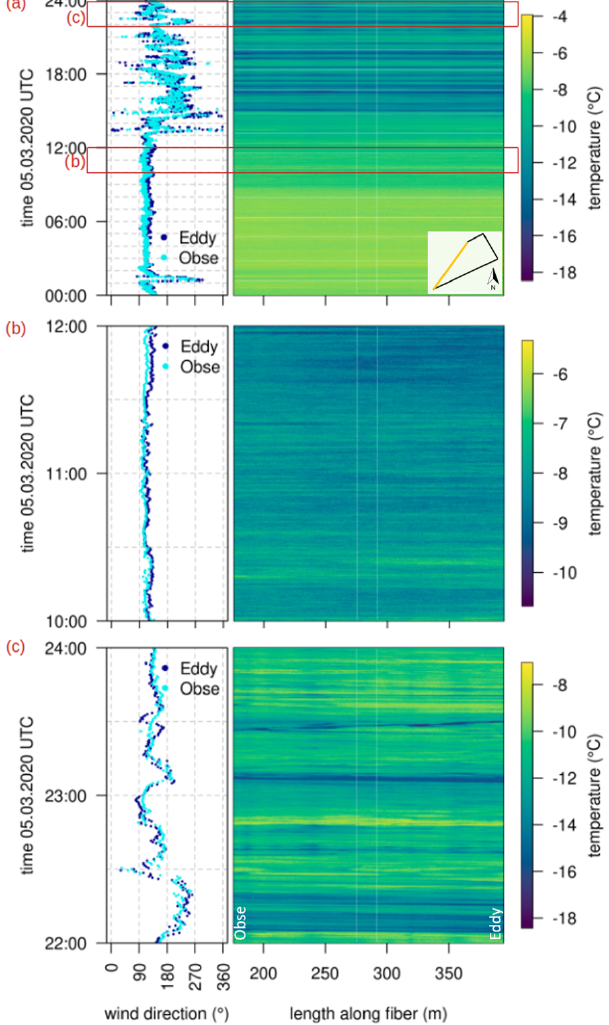
Figure 4. Fiber-optic temperature along the OBSE–EDDY tran- sect and the ultrasonic anemometer wind direction (temporal reso- lution = 30s) at the OBSE and EDDY towers for the whole day on 5 March (a) and for two 2h subsets during the strong-wind regime in the morning (b) and weak-wind regime at night (c) .